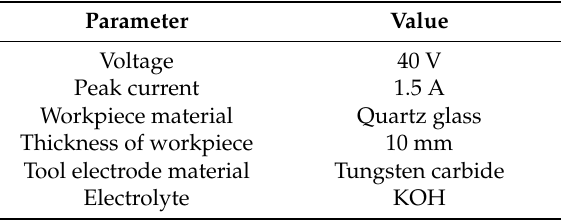
Figure 4. The appearance of the sparking phenomenon is observed when the gas film is formed. Table 1. The experimental parameters.